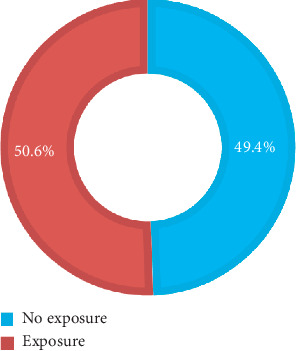
Exposure status of study participants.